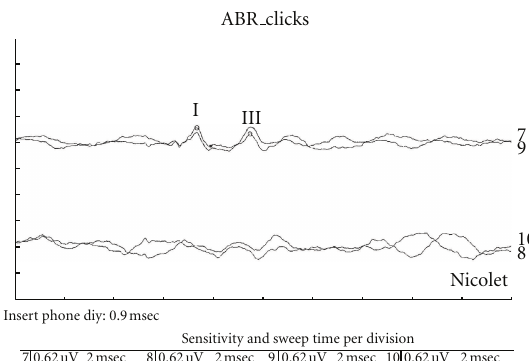
Figure 4: Abnormal auditory brainstem response waveform mor- phology consisting of an absent wave V ears in a patient with brainstem pathology secondary to closed head injury. Data are shown for ipsilateral and contralateral stimulation of the left